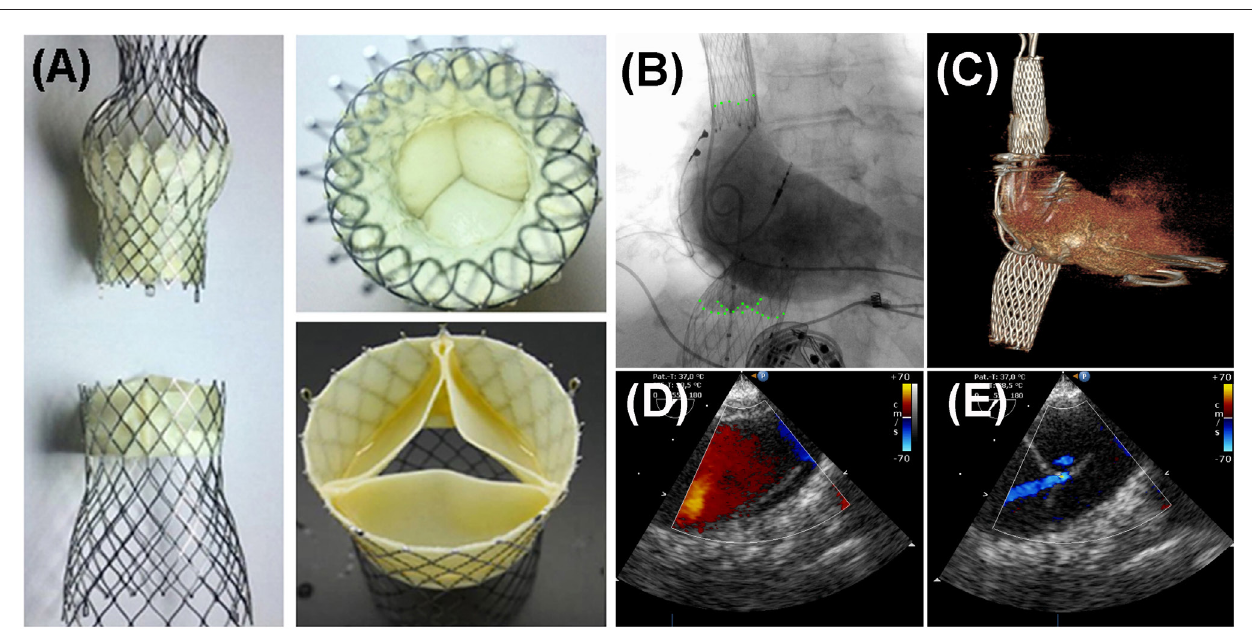
(C) Position of both valves is visualized by